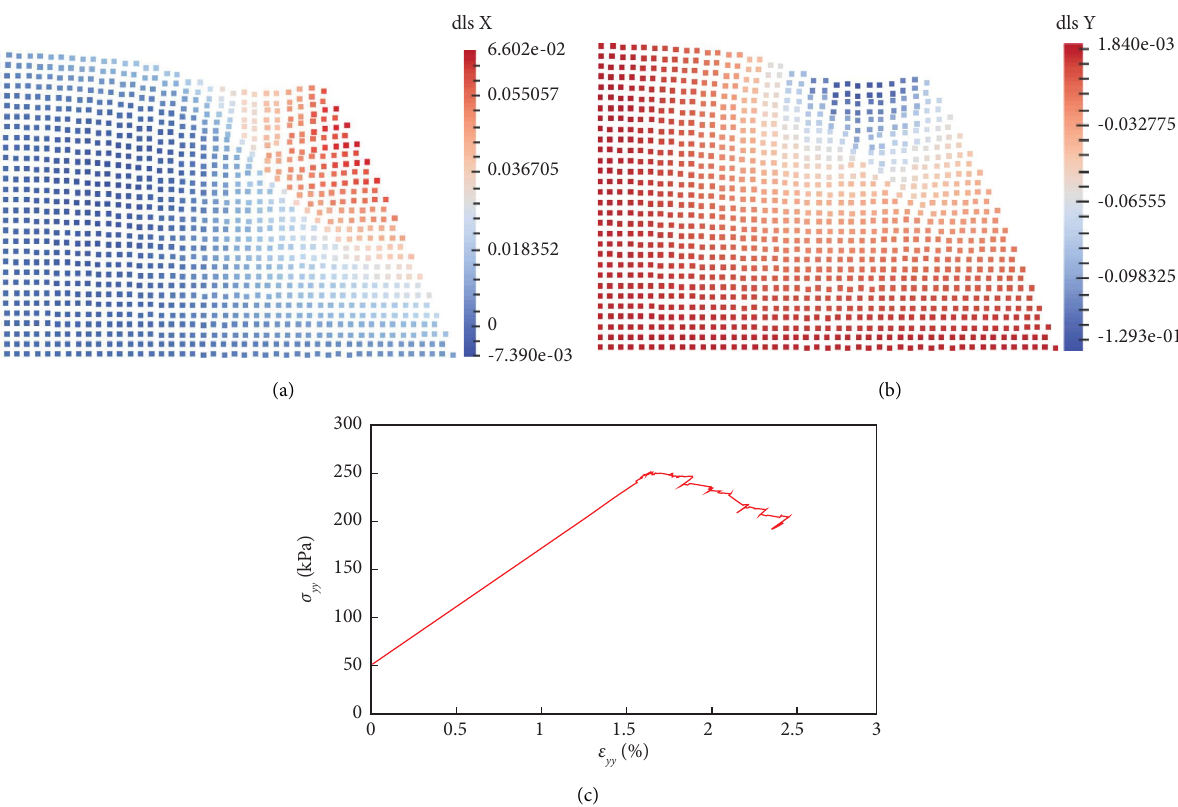
Figure 10: Displacement contours and stress-strain curves of the point located in the shear band under the surcharge load at the upper surface of the slope: (a) horizontal displacement; (b) vertical displacement; (c) stress-strain curve in the shear band (units of displacement: